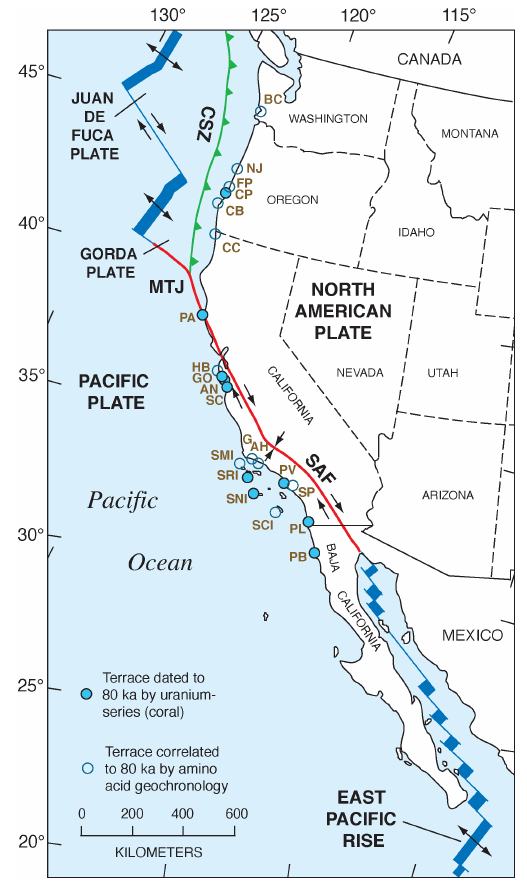
Figure 39. Map of the Pacific coast of North America with struc- tural features as shown in Fig. 2, but also plotted are localities (filled blue circles) where U-series ages of corals dating to MIS 5a ( ∼ 80ka) have been reported and localities (open blue circles) where amino acid ratios in mollusks permit correlation to MIS 5a. Structural features are redrawn in simplified form from Drummond (1981) and Simkin et al. (2006). Abbreviations are keyed to Ta- ble S3 and are as follows: BC: Bay Center, Willapa Bay; NJ: New- port Jetty; FP: Five Mile Point; CP: Coquille Point; CB: Cape Blanco; CC: Crescent City; PA: Point Arena; HB: Half Moon Bay; GO: Green Oaks Creek; AN: Point Año Nuevo; SC: Santa Cruz; G: Gaviota; AH: Arroyo Hondo; SMI: San Miguel Island; SRI: Santa Rosa Island; SNI: San Nicolas Island; PV: Palos Verdes Hills; SP: San Pedro; SCI: San Clemente Island; PL: Point Loma; PB: Punta Banda; CSZ: Cascadia Subduction Zone; MTJ: Mendocino Triple Junction; SAF: San Andreas Fault.